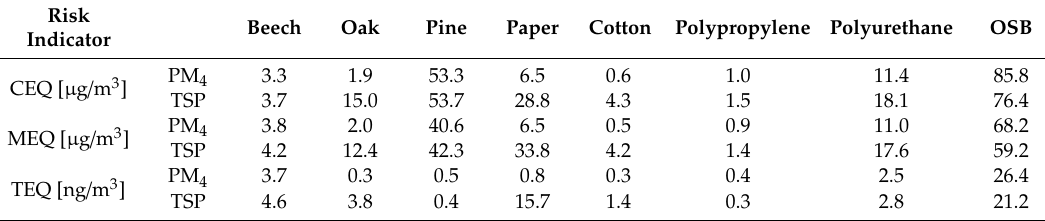
OSB—oriented strand board.